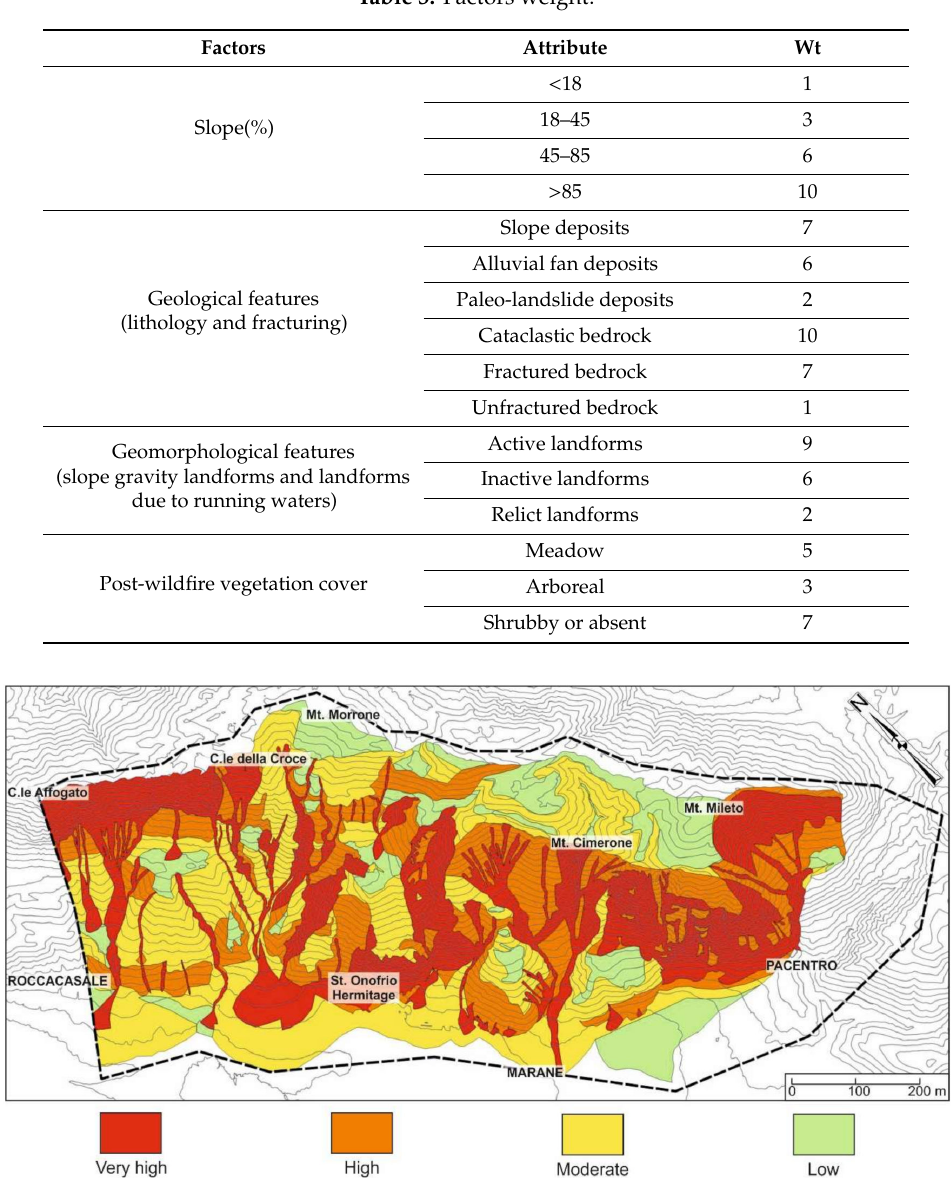
Table 3. Factors weight.